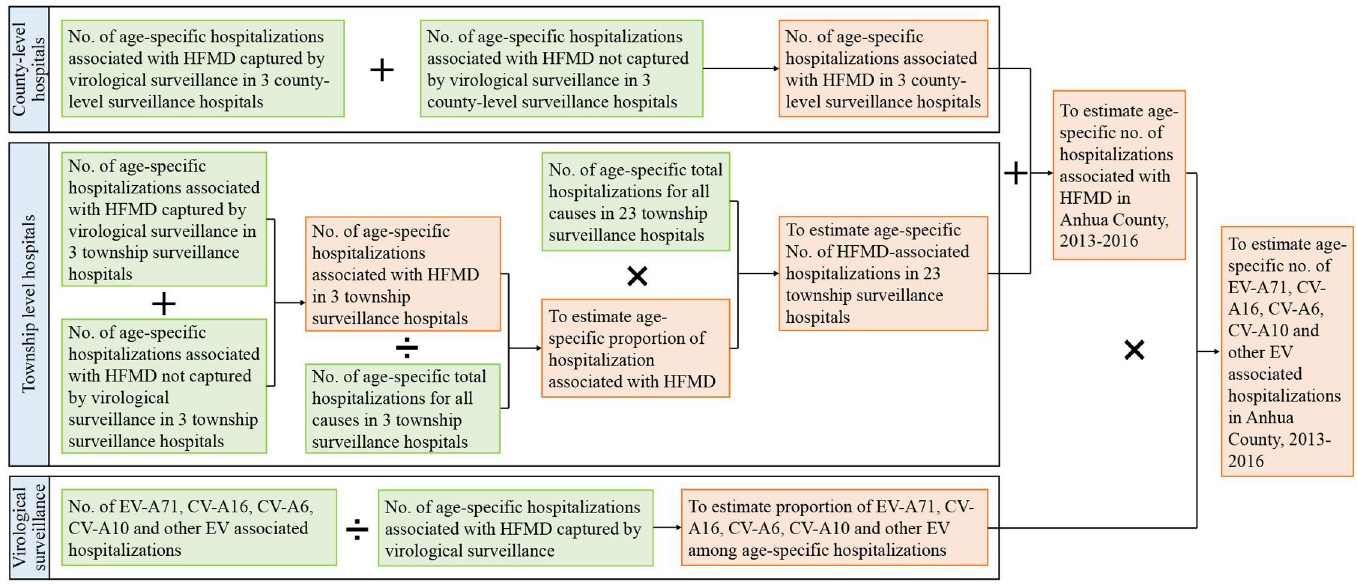
Fig 1. Flowchart of estimating age-specific and serotype-specific hospitalization burden associated with HFMD.